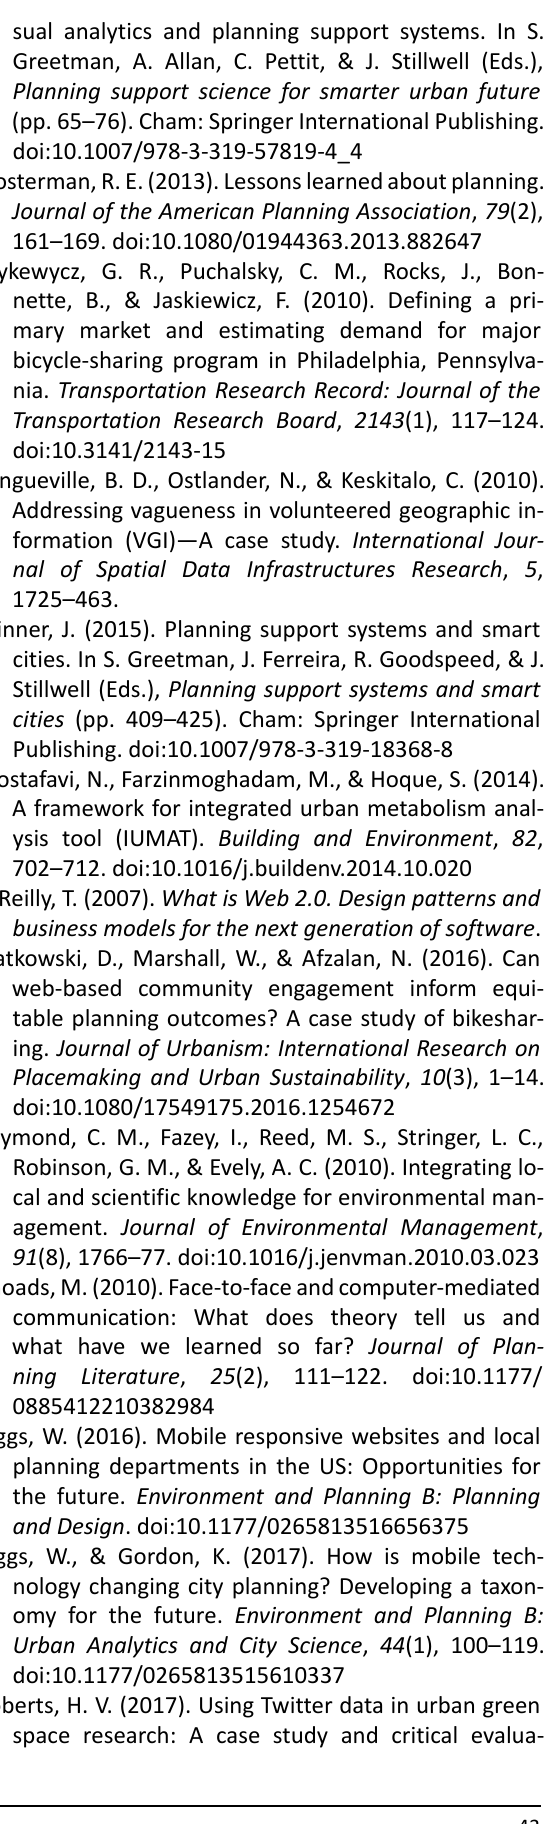
table planning outcomes? A case study of